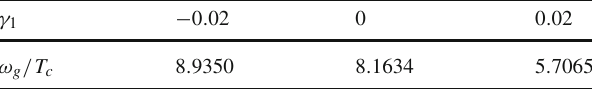
Table 8 The superconducting energy gap ω g / T c of σ yy with different γ